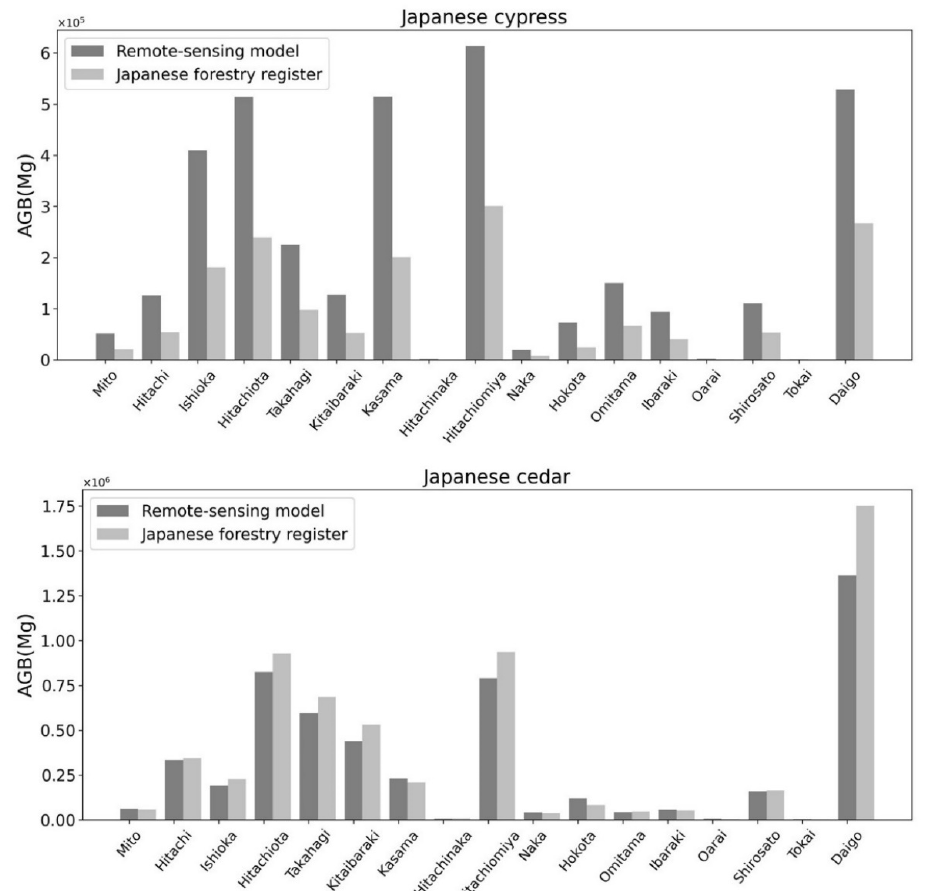
Figure A1. The aboveground biomass (AGB) estimated by the remote-sensing model and recorded in the Japanese forestry register for Japanese cedar and Japanese cypress in the 17 targeted cities in Ibaraki Prefecture.